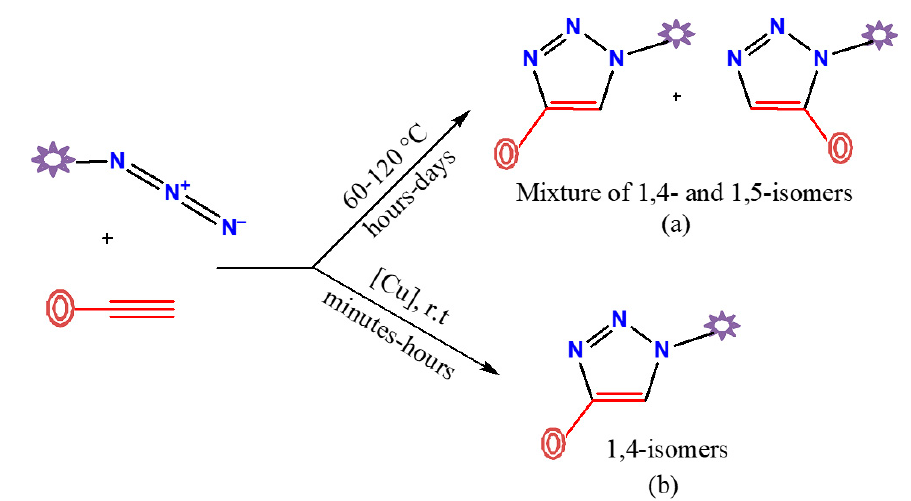
Figure 2. Non-regioselective ( a ) and regioselective ( b ) preparative routes of disubstituted-1,2,3-triazole derivatives by reaction between azides and alkynes.